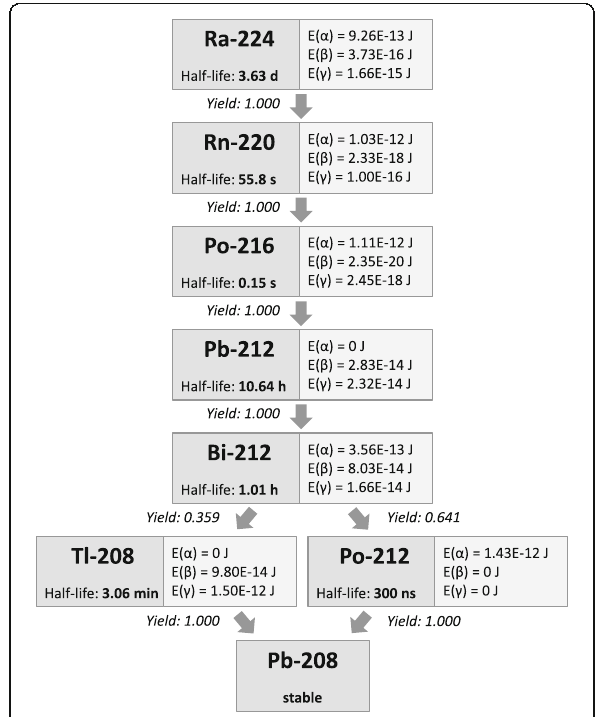
Fig. 1 Decay chain of Ra-224 with data on half-lives [23] and energy deposition per transition [22]. E( α ) and E( β ) state the energy per transition for the α -particles and recoil nuclei ( α ) and the β -particles, conversion electrons and Auger electrons ( β ) considered for the calculation of the absorbed doses to the blood. E( γ ) states the energy per transition for the X- and γ -radiation. However, E( γ ) was not considered for the calculation of the absorbed doses to the blood due to the low interaction probability in the geometry of the incubation